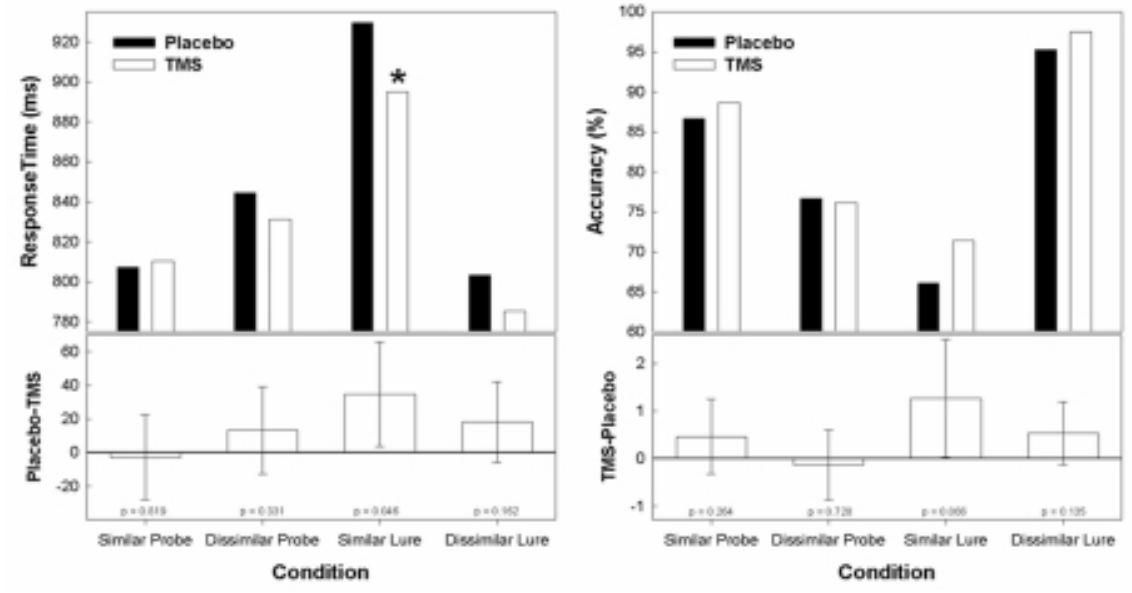
Fig. 3. Response time and accuracy plots for LIP stimulation, The left plot shows a graph of mean response time for TMS (white bars) and placebo (black bars) stimulation for the 4 behavioral conditions – (a) phonologically similar probes, (b) phonologically dissimilar probes, (c) phonologically similar lures, and (d) phonologically dissimilar lures. The lower portion of the plot shows the latency difference between TMS and placebo simulation plotted with 95% confidence intervals. Results from two-tailed paired samples t-tests are indicated for each condition. Average response times were computed based on correct trials only. An asterisk denotes conditions with significant behavioral differences between TMS and placebo stimulation (as visualized by confidence intervals that do not include zero). The right plot displays analogous graphs for the accuracy